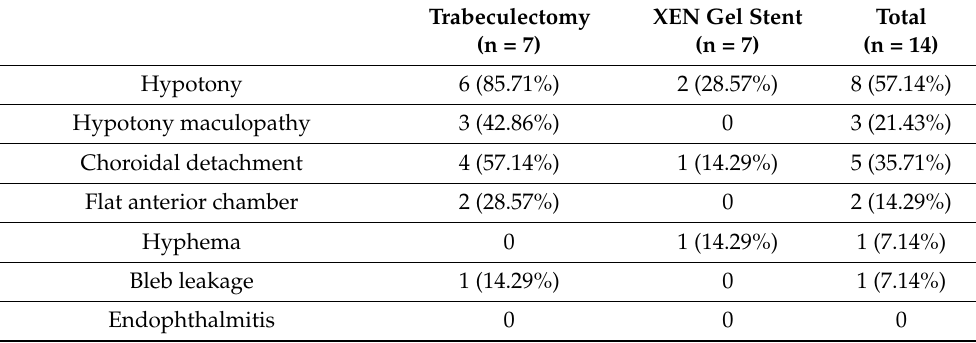
Table 3. Postoperative complications.